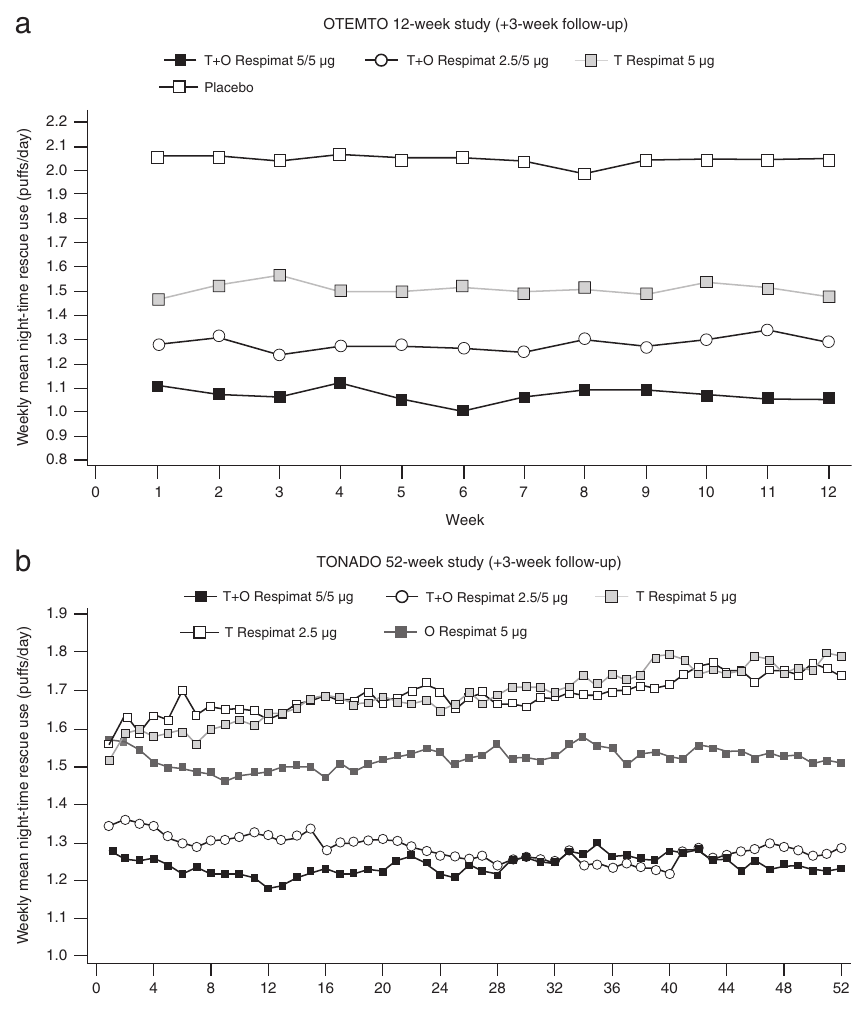
Fig. 5 Adjusted weekly mean night-time rescue medication use over 12 weeks in the OTEMTO studies ( a ) and 52 weeks in the TONADO studies ( b ). O, olodaterol; T, included data for all active treatments within the fi gures and tables. All treatments were delivered via the Respimat inhaler.